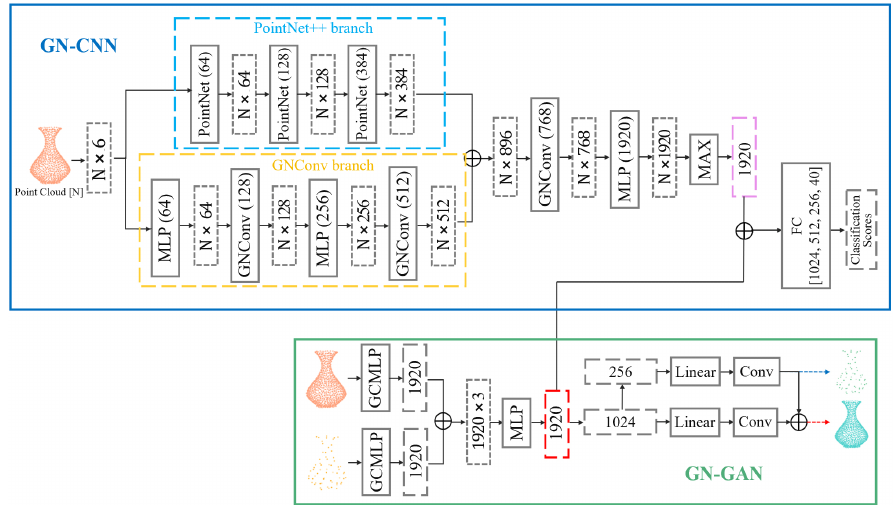
Figure 2. The overall architecture of the proposed method. The architecture includes two essential networks, GN-CNN and GN-GAN. GN-CNN is our backbone network for classification and few-shot learning. GN-GAN is for the reconstruction task and is pre-trained to obtain the prior knowledge (represented by the red box) to warm start GN-CNN.